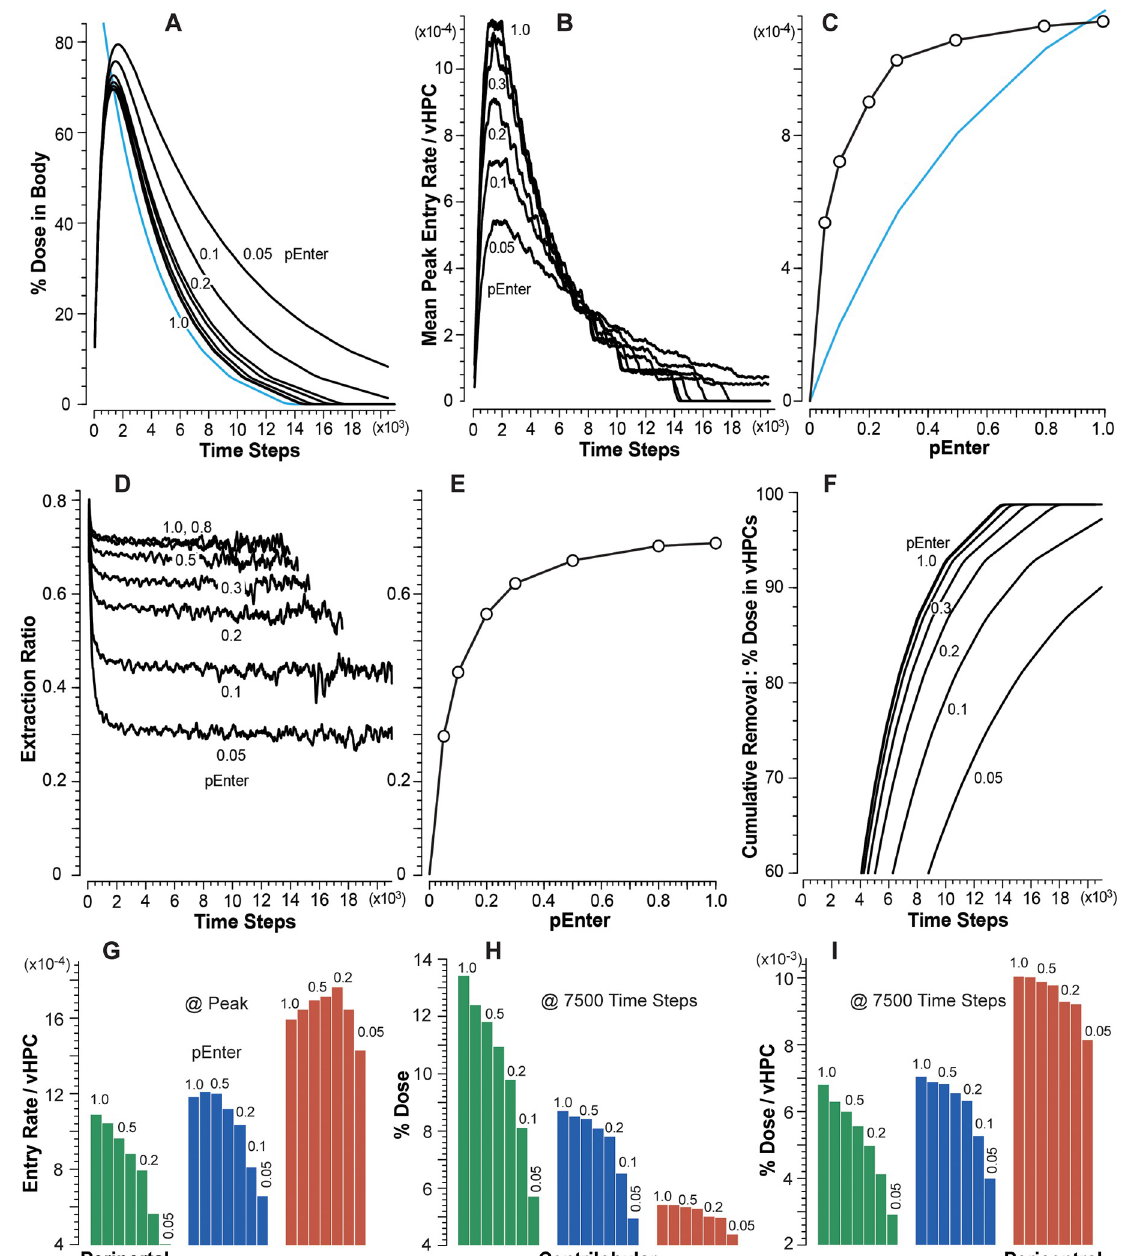
Fig 7. Results from vHuman experiments using vC2. (A) Temporal measures of percent Dose in Body for each pEnter . Blue profile: all vC2 was added to Media at t = 0. (B) Mean Entry rates for each pEnter (Entry rates = removal rates). (C) Correlation between mean peak Entry rates and pEnter . To facilitate comparisons, the blue curve traces the corresponding values from Fig 6C. (D) Temporal measures of Extraction Ratio for each pEnter . For p � 0.2, measures terminate early because (essentially) all vC2 has been removed. Variance increases with time because smaller amounts are measured. (E) Correlation between mean plateau Extraction Ratios and pEnter . (F) Temporal measures of cumulative percent Dose in vLiver for each pEnter . Note that, compared to Fig 6F, vLiver removal of vC2 is strikingly more efficient. (G) Peak Entry rates for each pEnter within the three bands in Fig 3A. Corresponding measures of percent Dose (H) and percent Dose per vHPC (I) at 7500